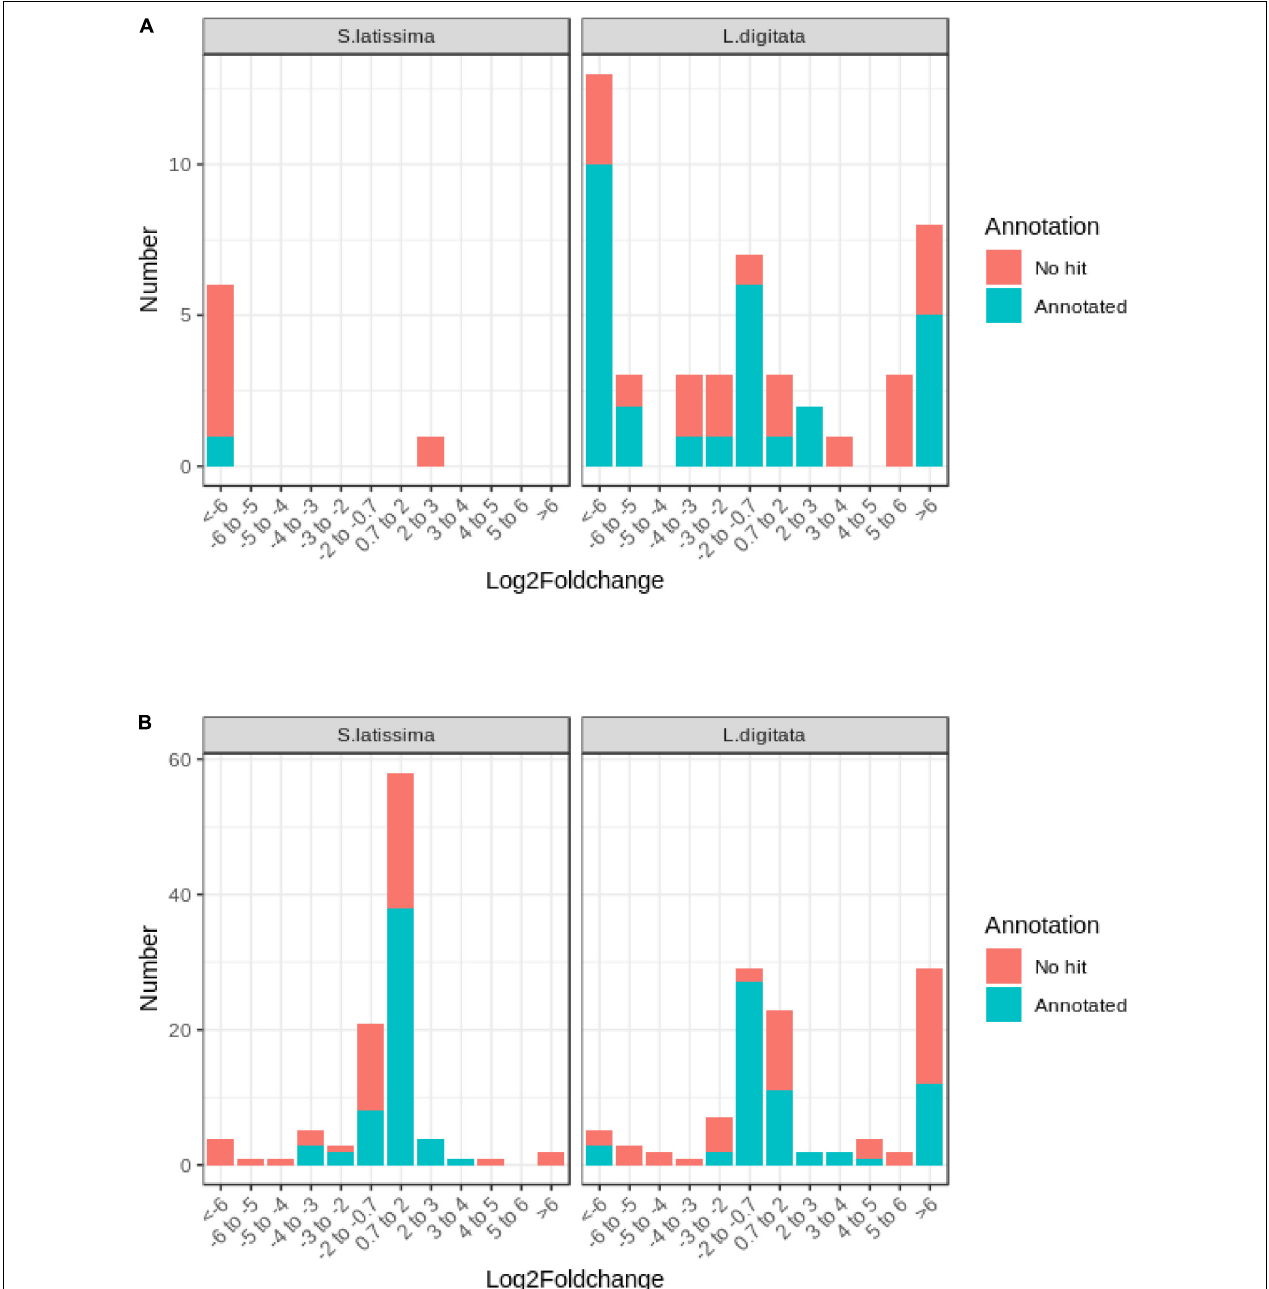
FIGURE 3 | Frequency distribution of log2FC among differentially expressed genes in S. latissima and L. digitata after (A) 24 h and (B) 48 h of co-cultivation with L. elsbetiae